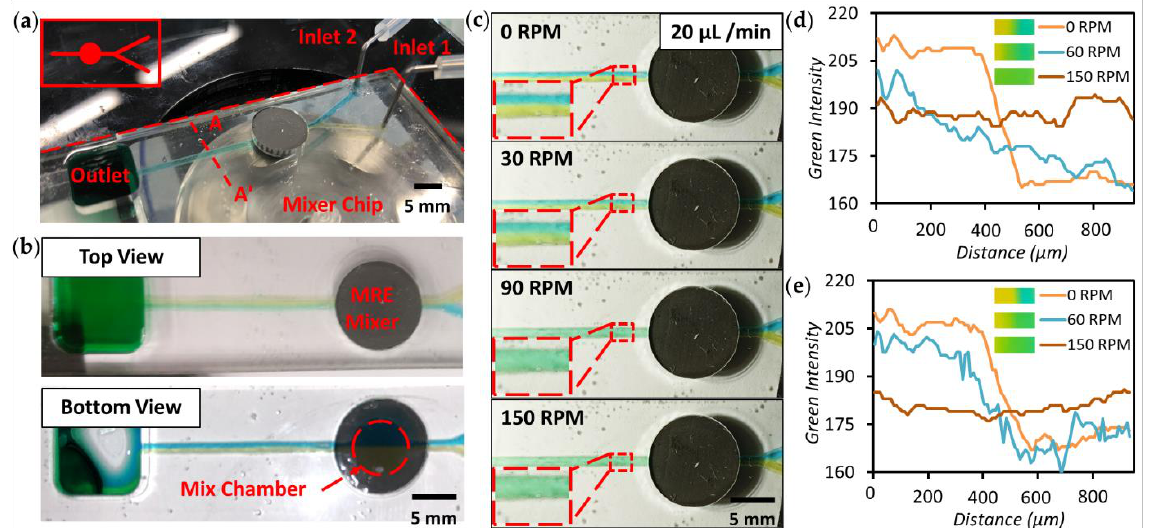
Figure 3. Experiments for examining on-chip MRE micromixer performance. ( a ) Actual image for the integrated MRE micromixer. The upper insert shows the microchannel design. ( b ) Top and bottom views of the micromixer channels. ( c ) Snapshots showing the mixing performance at inlet flow rates of 20 µL/min. Plot of the green colour intensity profiles along A- A’ shown in ( a ) across the microchannel at a flow rate of ( d ) 40 µL/min and ( e ) 100 µL/min with the magnet rotor rotating at speeds of 0, 60 and 150 RPM. Images of the channels at different RPMs are shown next to the legend.